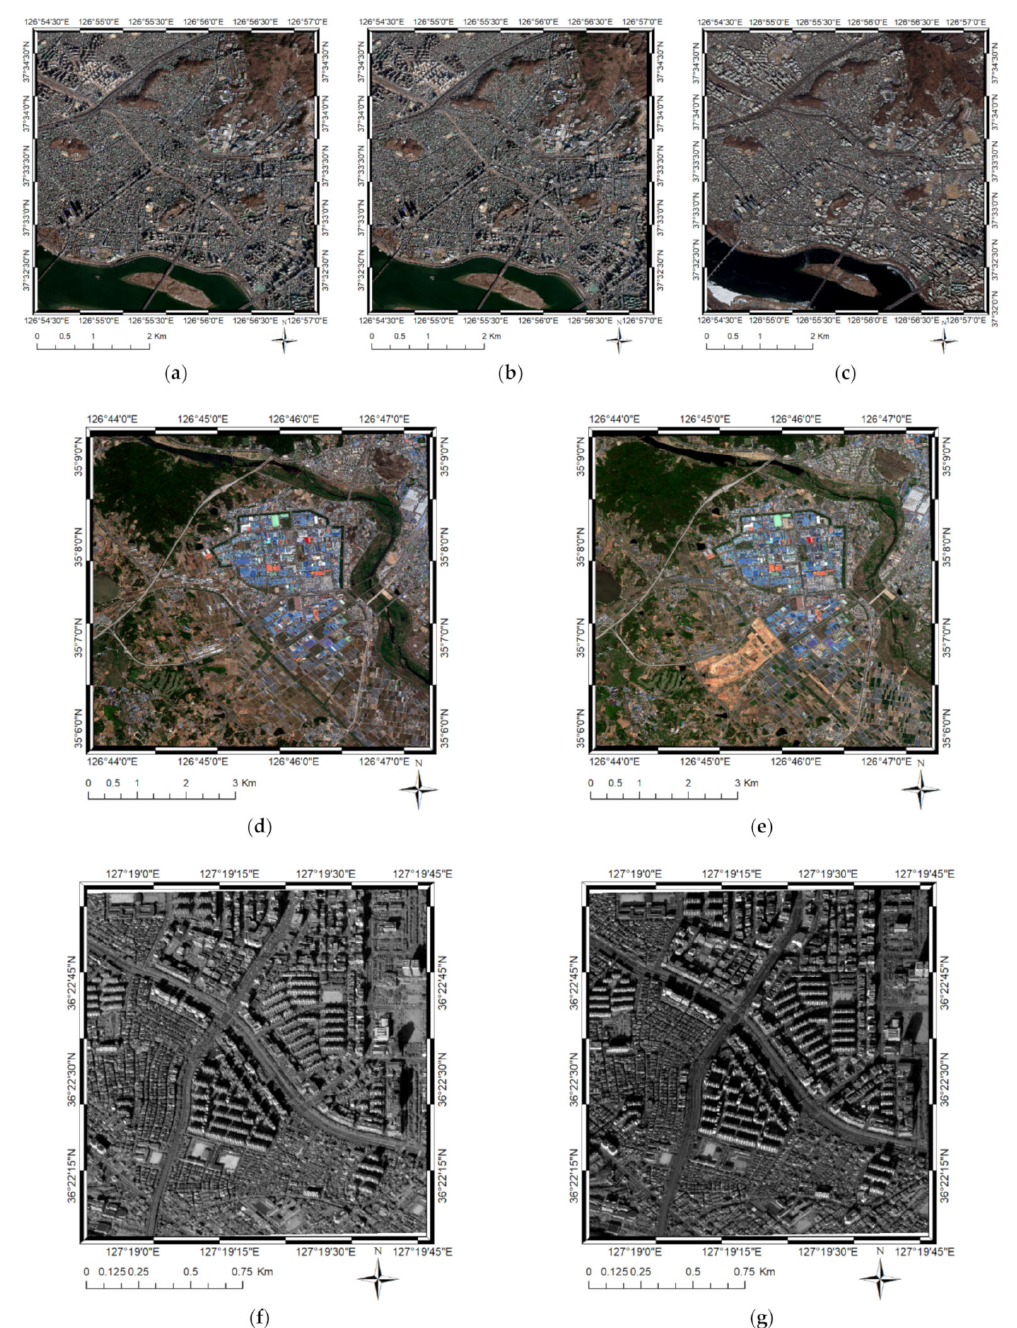
Figure 3. Datasets constructed from Worldview-3 and Kompsat-3A sensor data: ( a ) Reference image from the simulated and the first real dataset (Worldview-3), ( b ) sensed image from the simulated dataset (Worldview-3), ( c ) sensed image from the first real dataset (Worldview-3), ( d ) reference image from the second real dataset (Worldview-3), ( e ) sensed image from the second real dataset (Worldview-3), ( f ) reference image from the third real dataset (Kompsat-3A), and ( g ) sensed image from the third real dataset